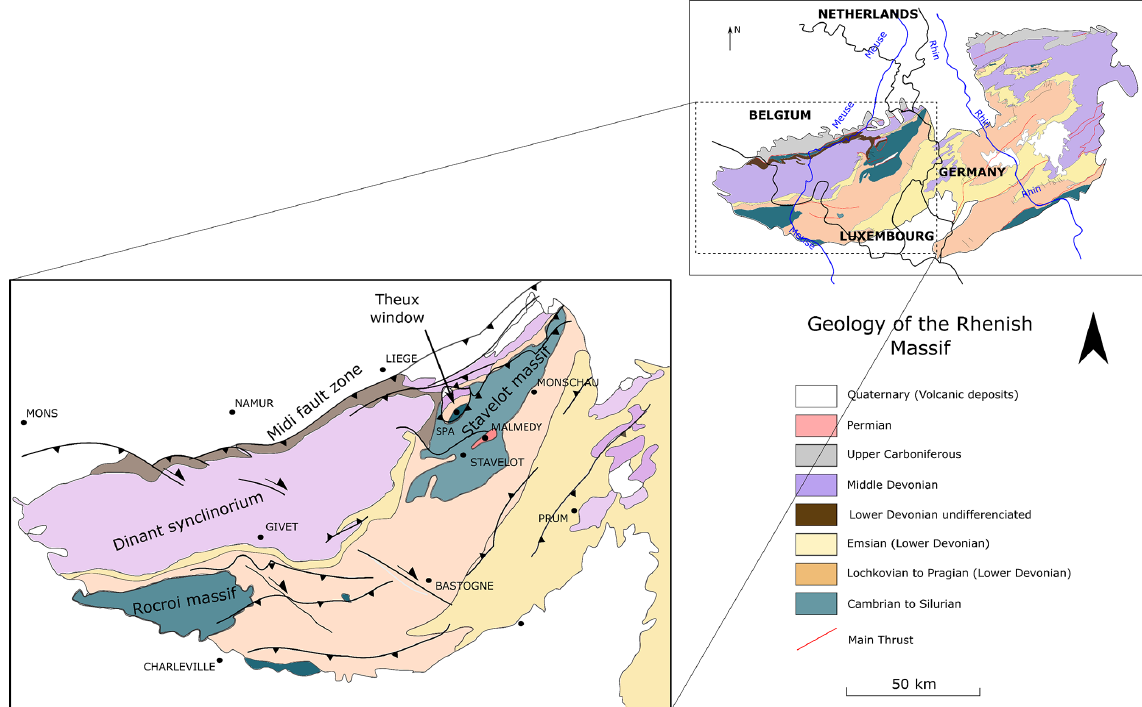
Figure 1. Simplified geology of the Ardennes Allochthon and its localization in western Europe and in the Rhenish Massif, modified after Fielitz and Mansy (1999).